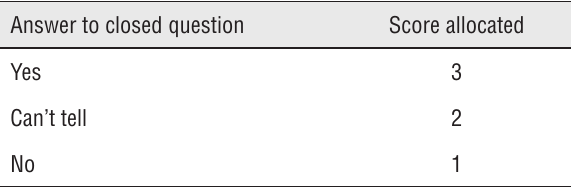
Table 4 – The scoring system for individual questions in the CASP list.